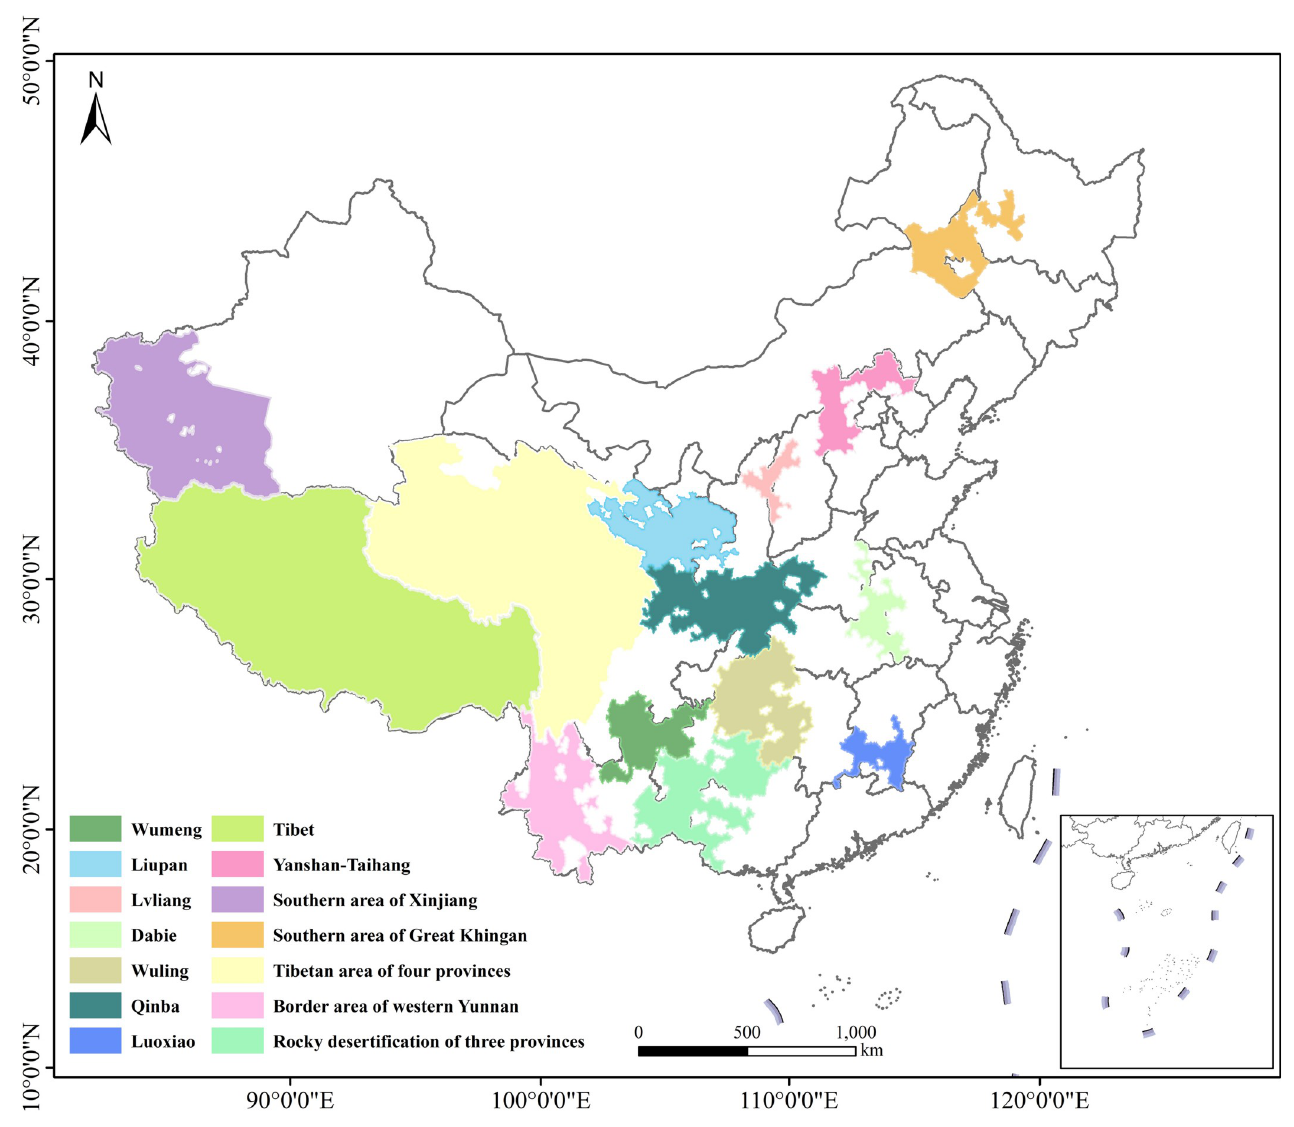
Fig 1. The spatial distribution of 14 contiguous poverty areas in